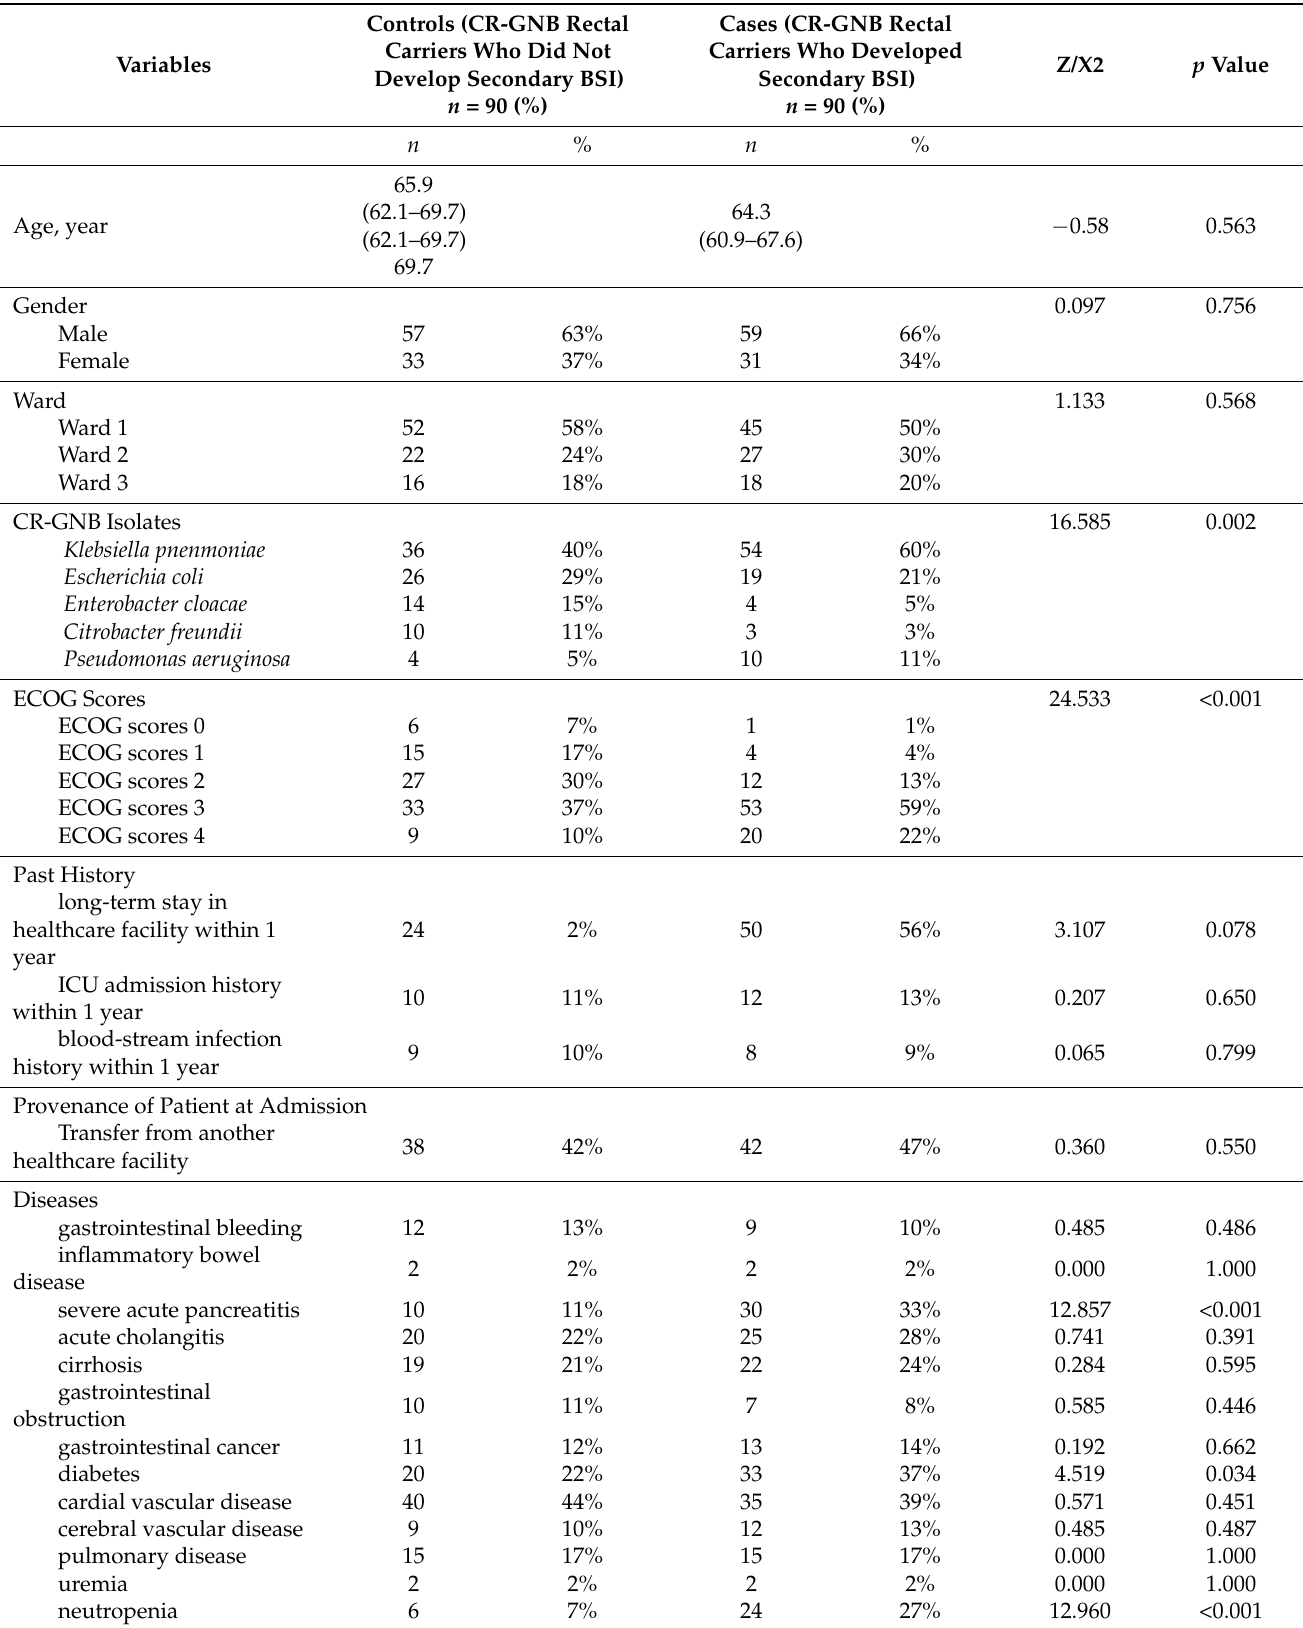
Table 1. Demographic and clinical characteristics of patients of both case and control